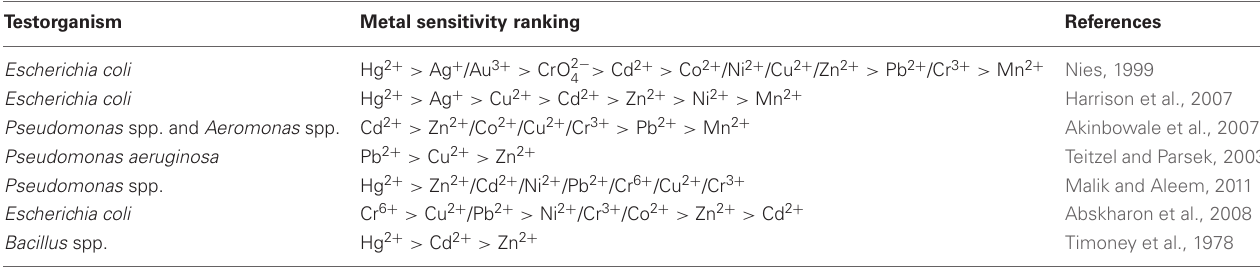
Table 2 | Toxicity ranking of heavy metals in recent